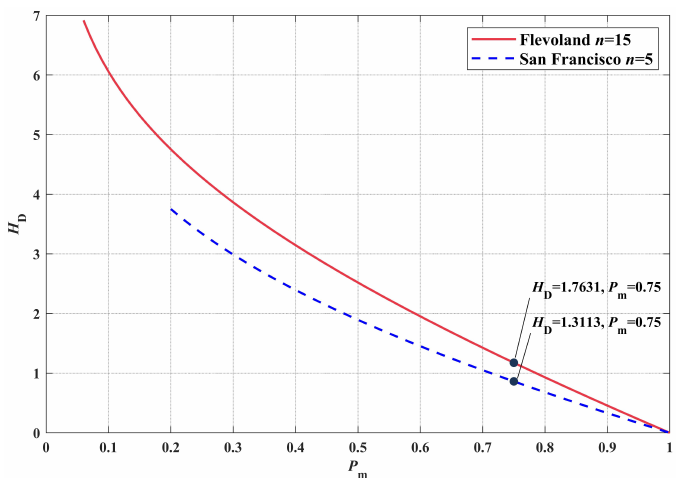
Figure 7. H D - P m curve.